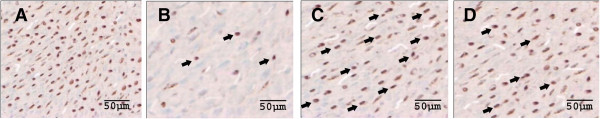
Immunohistochemical expression pattern of Bcl-2 in striatum. A: Control (group 1); B: MPTP induced (group II); C: MPTP induced + As treated (group III); D: Drug Control (group IV).